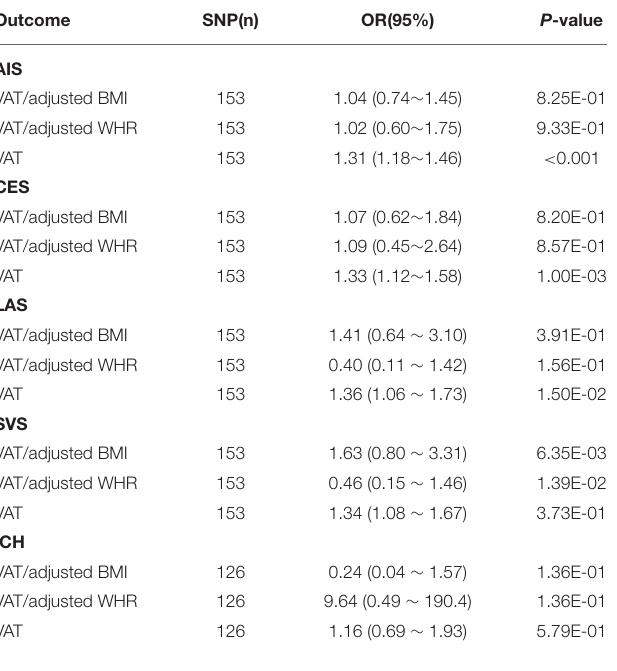
TABLE 2 | Results of Multivariable mendelian randomization using IVW method.